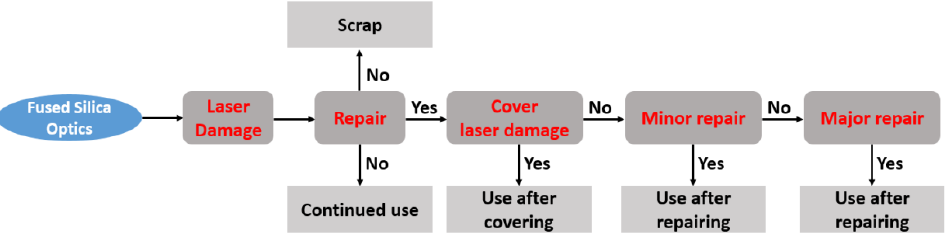
Figure 1. Use flow of fused silica optics.